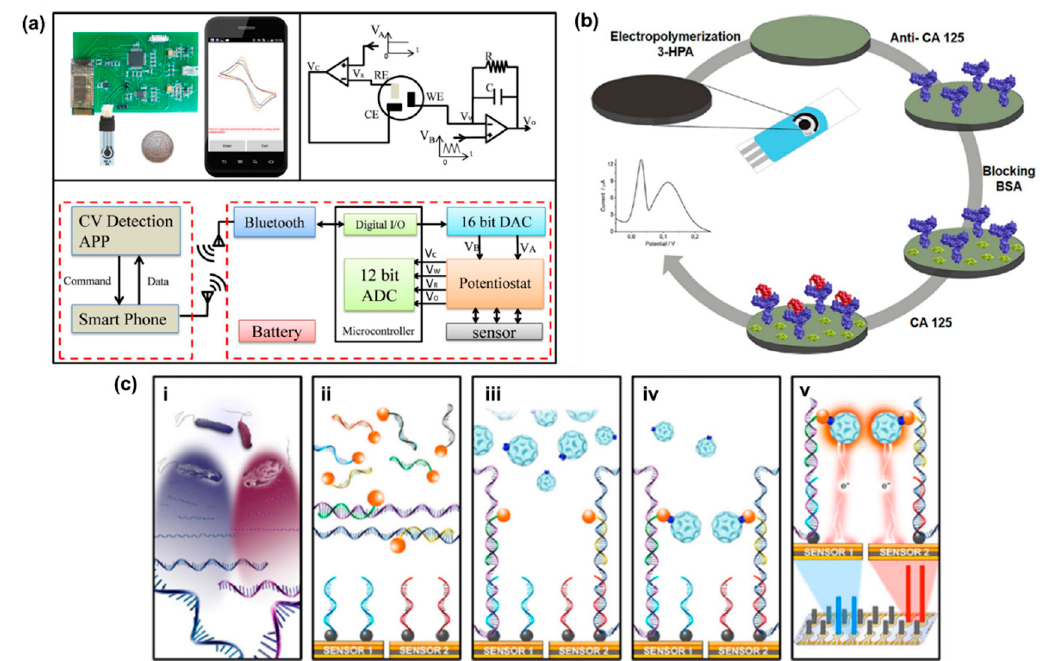
Figure 23. Schematics of hand-held ECBs with potential for POCT. ( a ) a smartphone-based ECB for the sensitive detection of glucose from blood samples. The figure shows the circuit setup that was used for connecting the ECB with the smartphone and detecting glucose through the CV technique [298]. ( b ) fabrication of a label-free immunosensor on a screen-printed carbon electrode (SPCE) strip for the detection of CA125 biomarkers from serum samples through the DPV technique [71]. ( c ) mechanism proposed for a clinically tested ECB for the simultaneous detection of multiplex pathogens for the diagnosis of urinary tract infection; (i) lysis of di ff erent bacteria through identification of 16S rRNA; (ii) hybridization with detector probes; (iii) combining with the capture probe immobilized on the electrode surface; (iv) binding of anti-fluorescein HRP tag to form sandwich system; and (v) generation of i-t current signal for a fixed potential that corresponded to the concentration of di ff erent bacteria present in the system [300]. Reprinted with permission from [71,298], Copyright © 2020 and 2020 published by Elsevier B.V. [300], Copyright © 2020 published by the American Urological Association. DAC: Digital-to-analog converter.